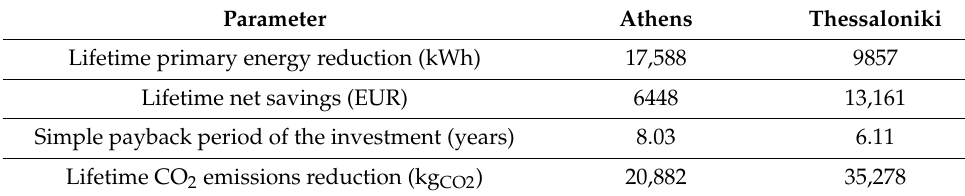
Table 5. Final assessment of both